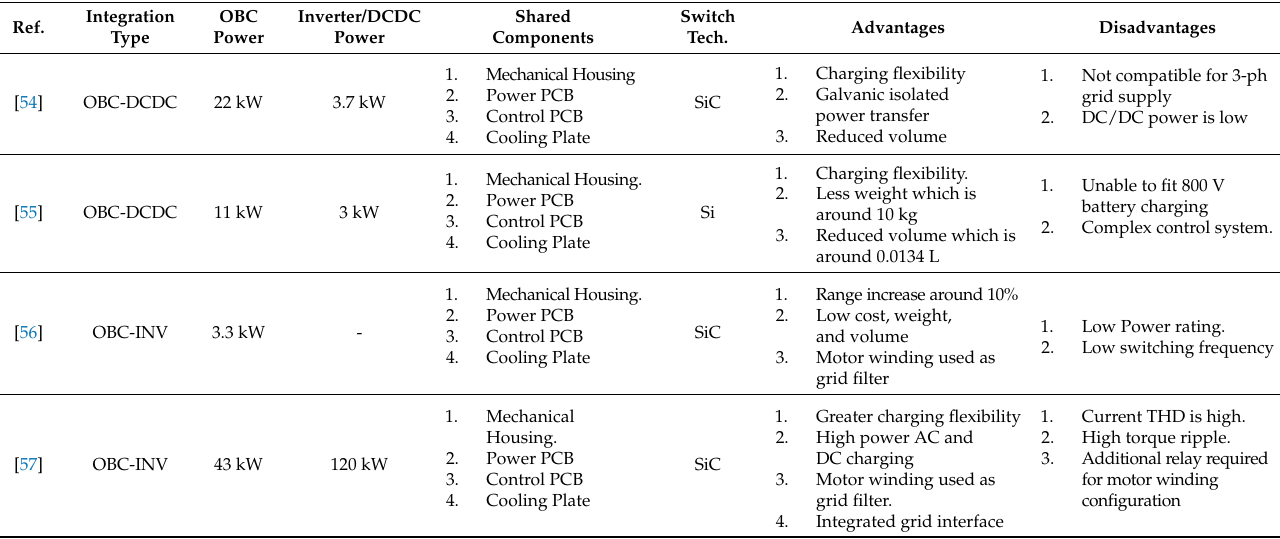
Table 3. Integrated OBC state-of-the-art prototypes.